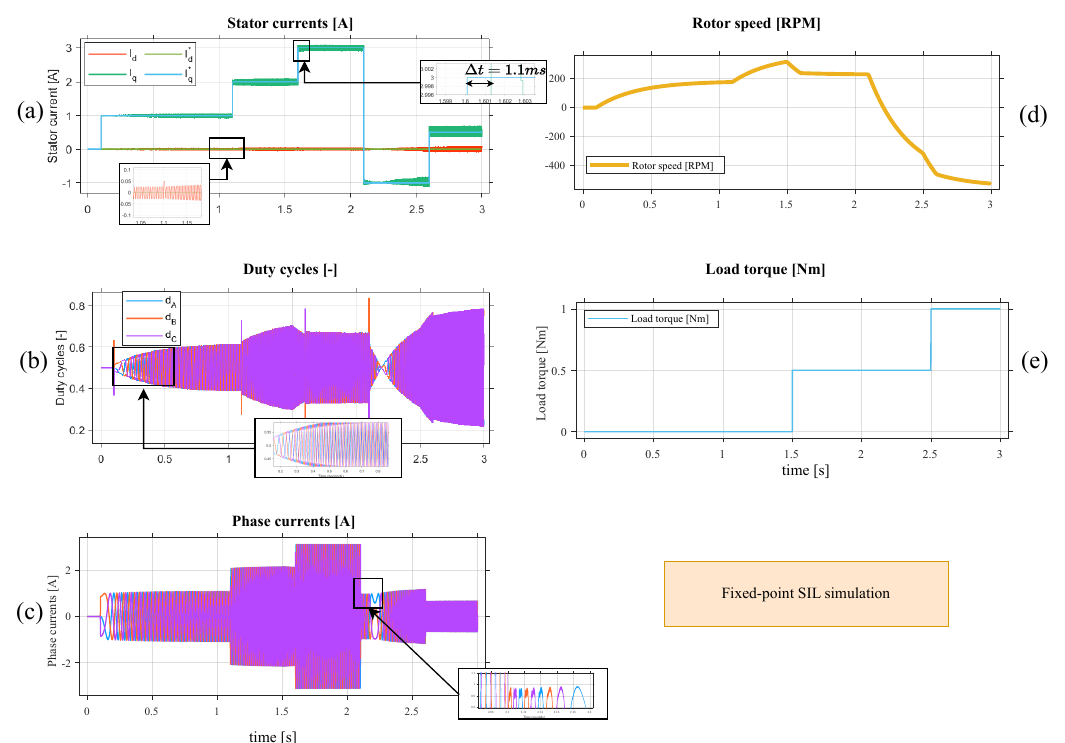
Figure 15. Software-in-the-loop simulation of the currents controller: ( a ) stator currents [A]; ( b ) three- phase duty cycles; ( c ) three-phase currents [A]; ( d ) rotor speed [RPM]; ( e ) load torque